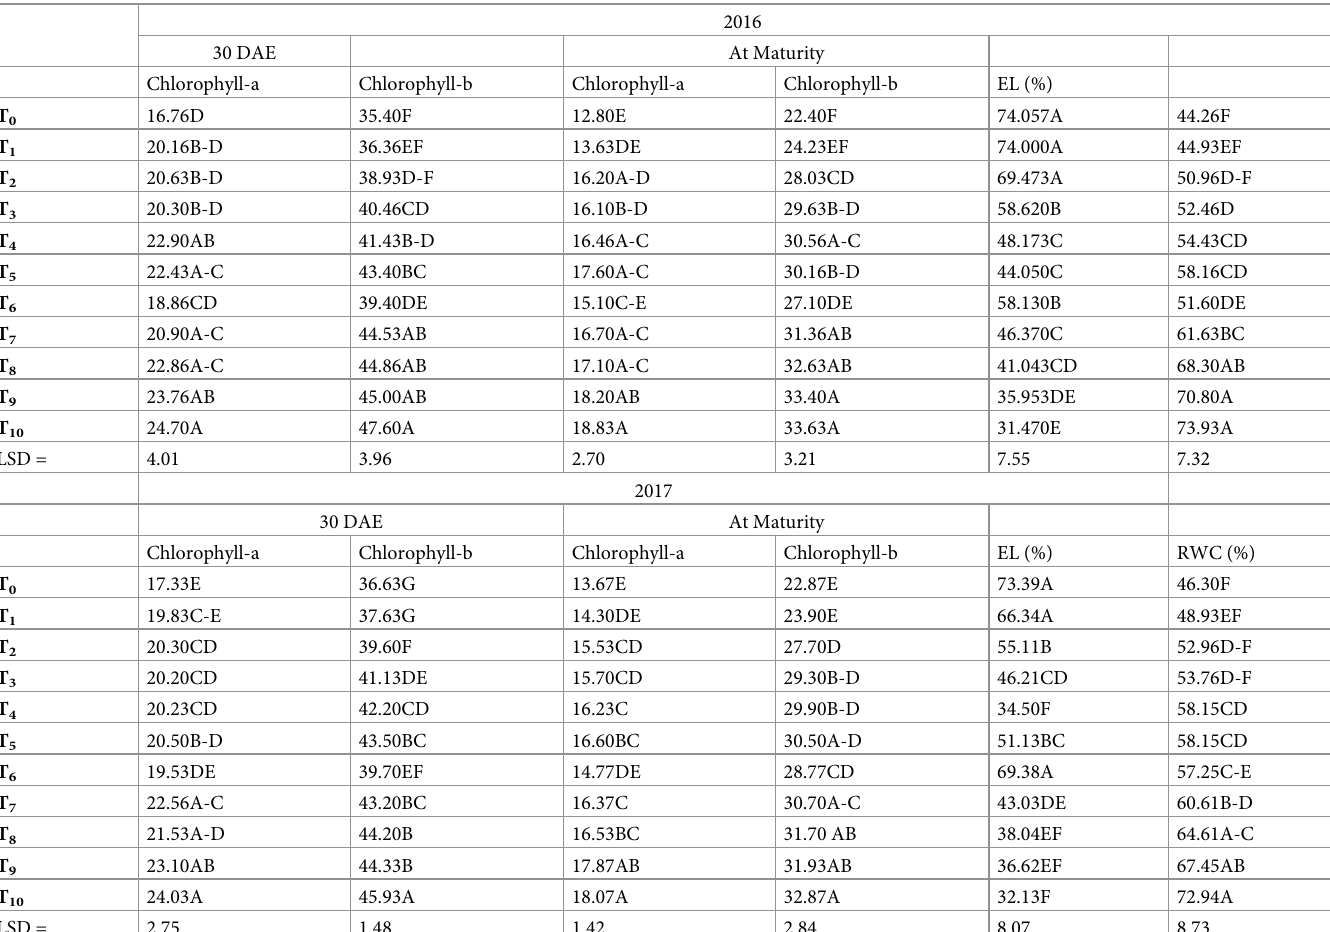
Table 4. Effect of Zn lysine chelate priming and inoculation of ZSB on biochemical traits and water relations of maize